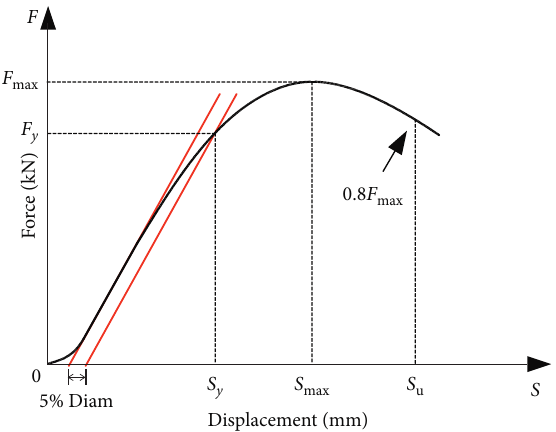
Figure 17: The method of 5% diameter used to determine the yield point.